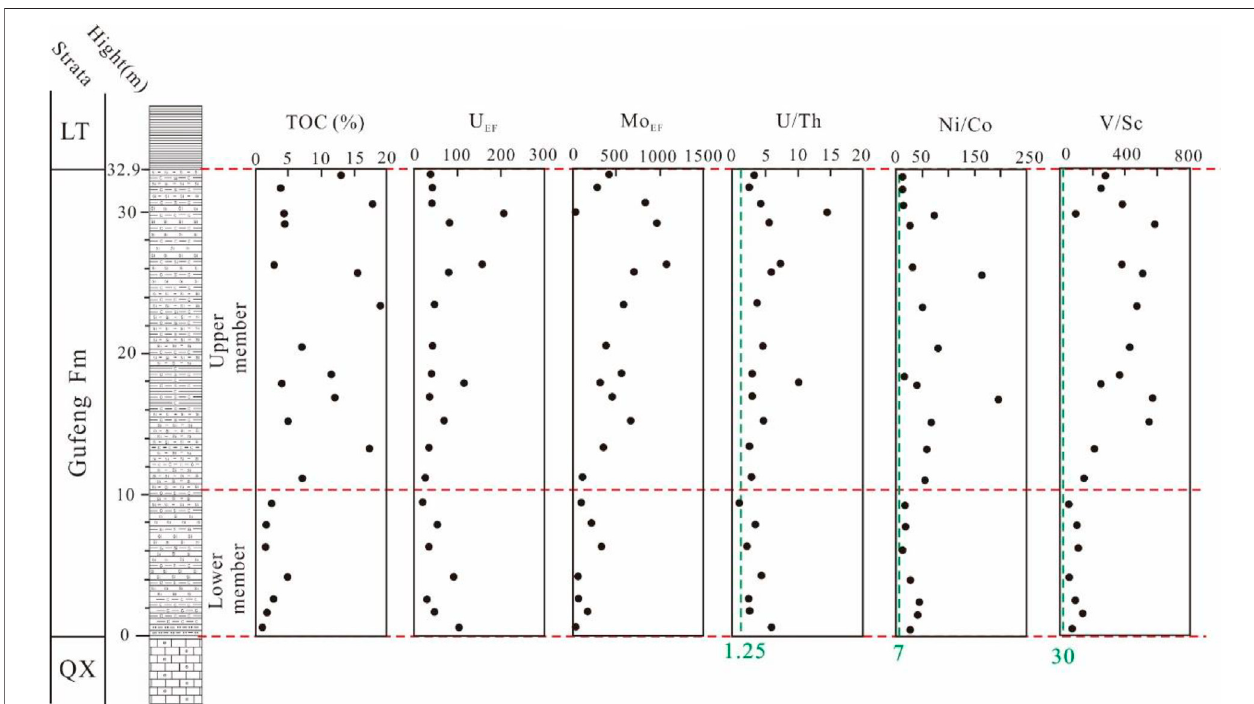
FIGURE 7 | Pro fi les of TOC, Mo EF , U EF , U/Th, Ni/Co, and V/Sc from the shale samples in the Gufeng Formation at the Putaoling section. QX, Qixia Formation; LT, Longtan Formation.